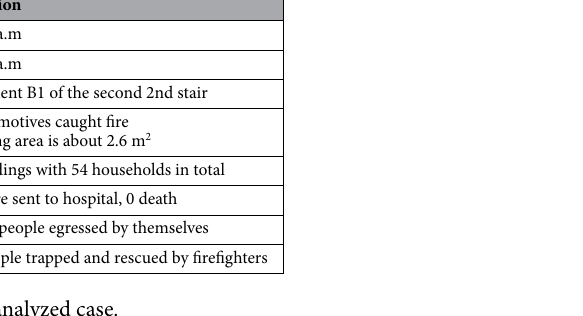
Table 2. The fire situation of the analyzed